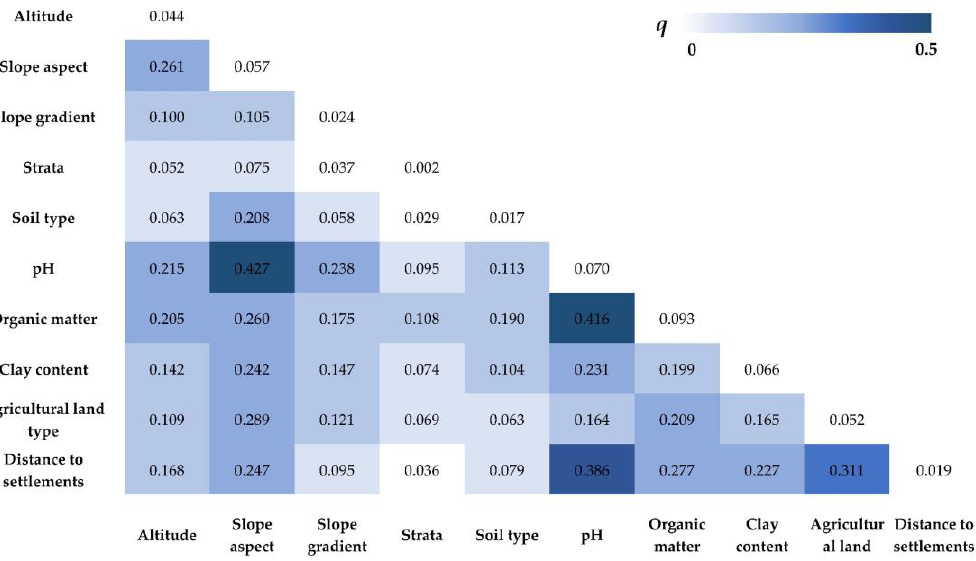
Figure 4. The interaction results of Pb by the interaction detector of the geographic detector.